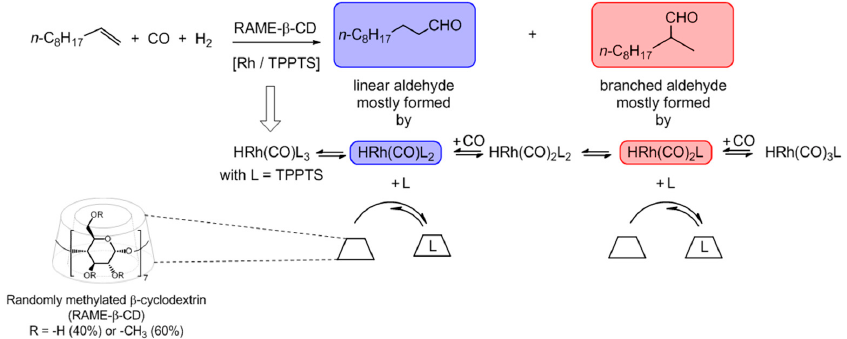
Table 1. Structure, abbreviation of the water-soluble phosphanes used, and value of the association constant (K) for the inclusion complexes between the RAME- β -CD and the phosphane.